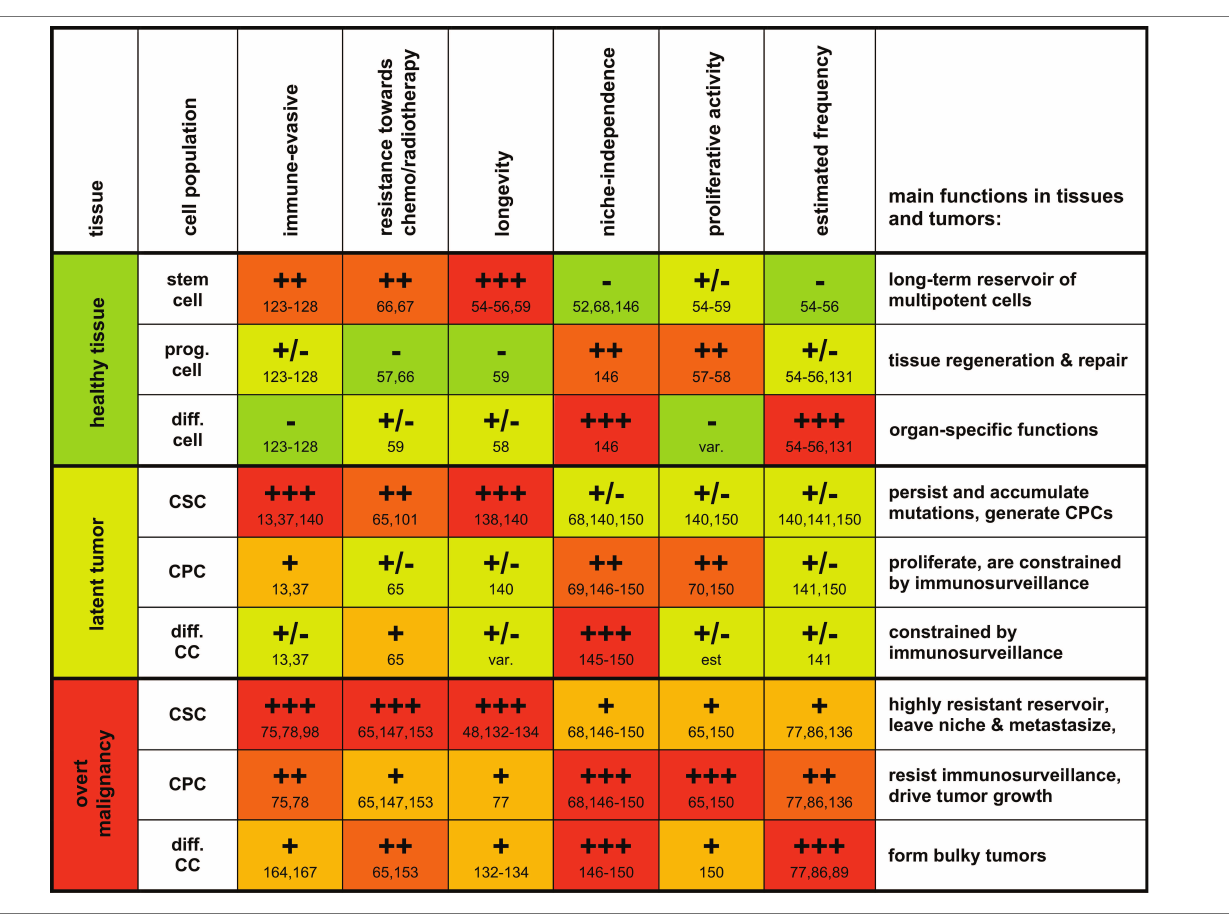
Table 1 |A grossly schematic overview summarizing characteristic properties and functions of stem cells, progenitor cells, and differentiated cells and their malignant counterparts